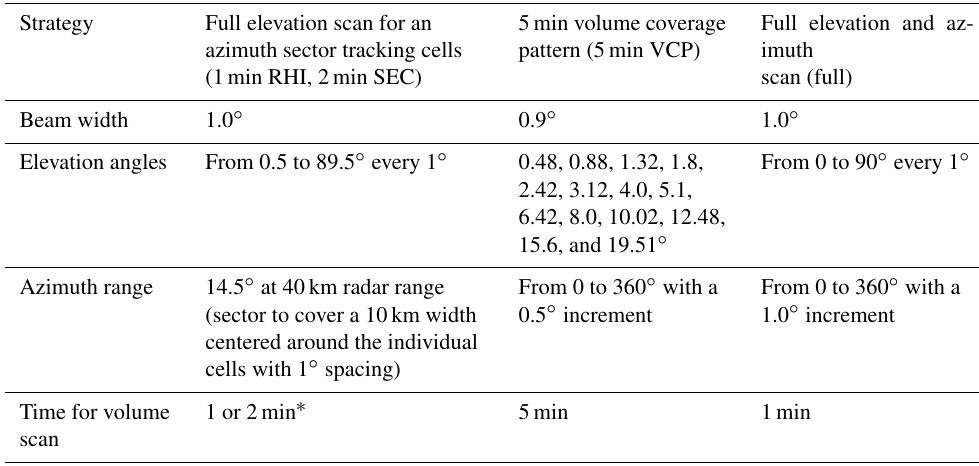
Table 1. Radar scan strategies simulated in this study.